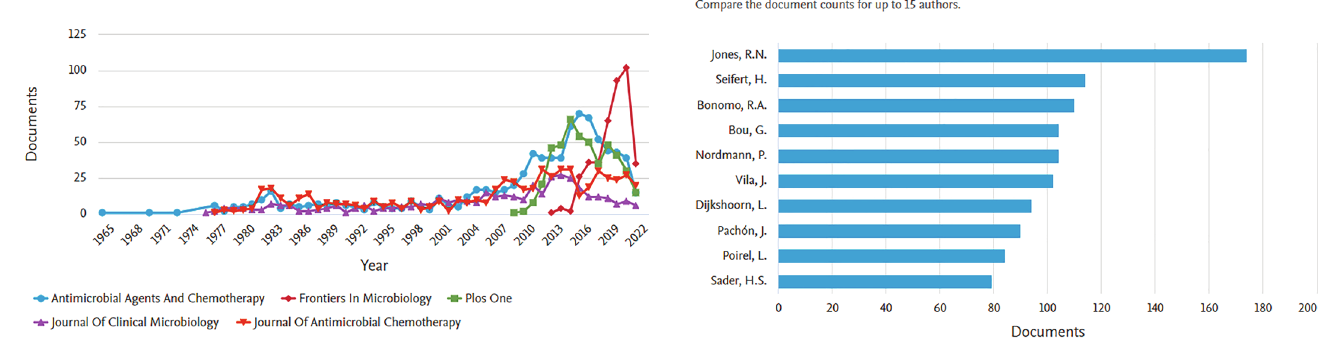
Figure 2 - Number publications according to journals contributing the most to the related literature on Acinetobacter.